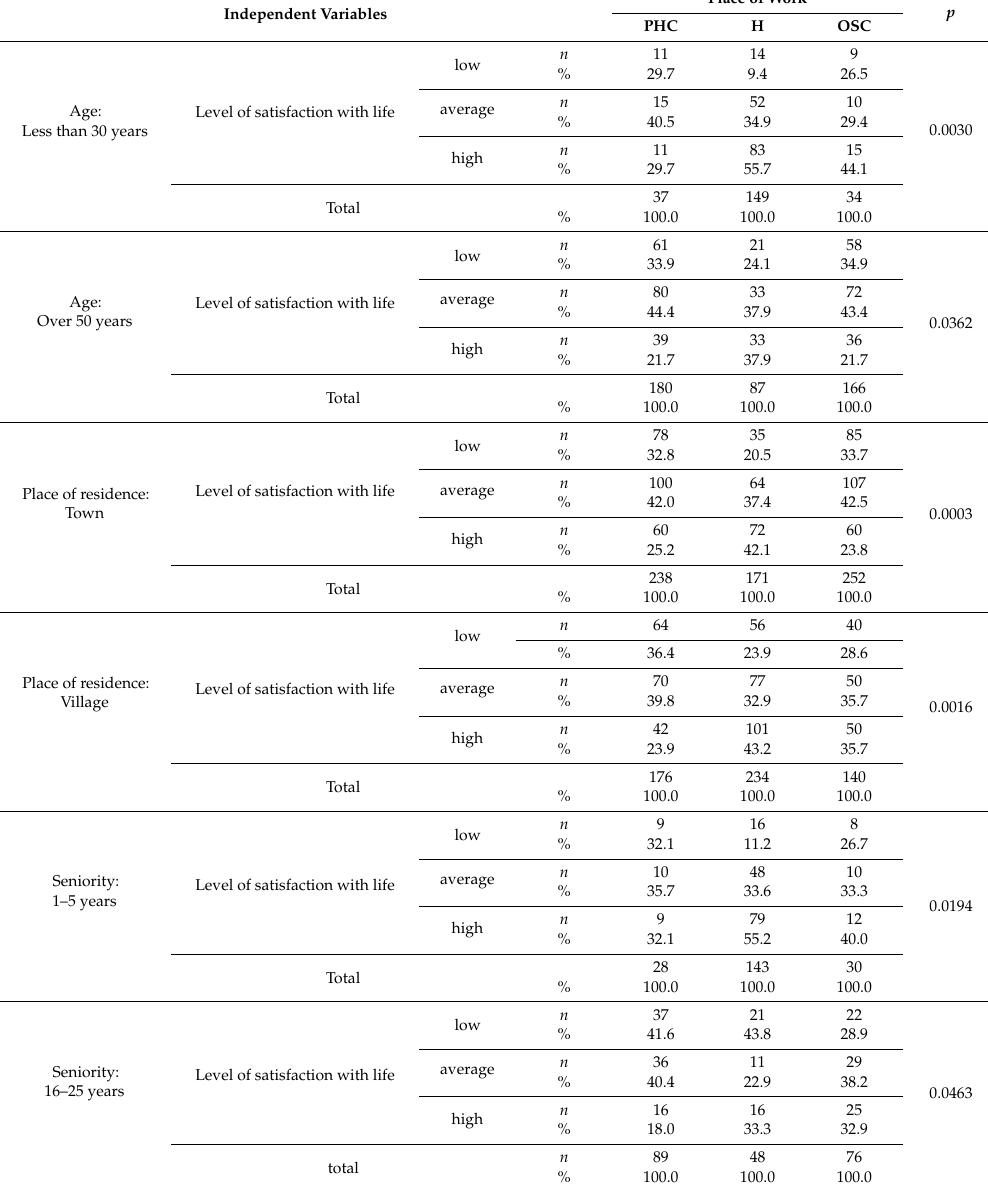
Table 3. Place of work and level of life satisfaction depending on age, place of residence, and seniority. Independent